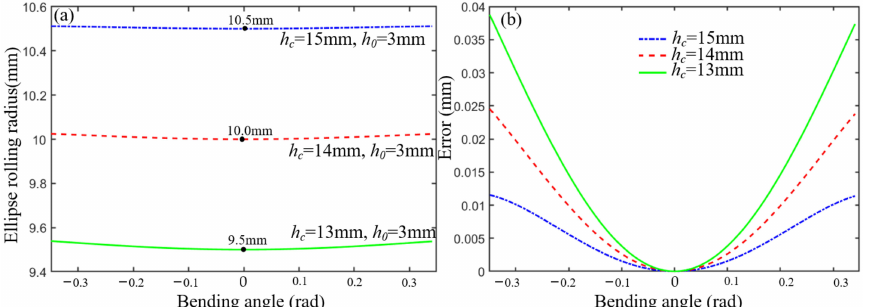
Figure 2. The influence of h c on R 0. ( a ) The relationship between the h c and ellipse rolling radius. ( b ) The error analysis between R 0 and R in different h c .